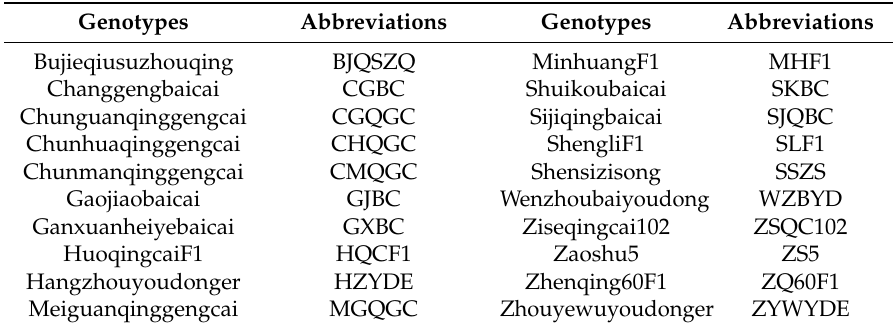
Table 1. Pakchoi genotypes used in the experiments and their abbreviations. Genotypes Abbreviations Genotypes